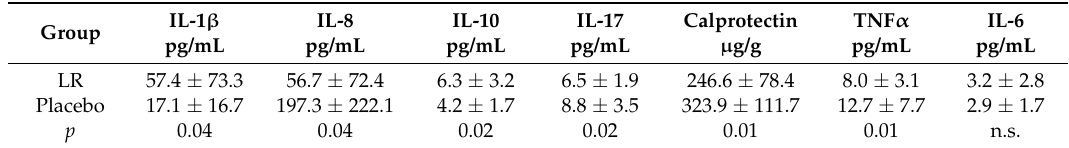
Table 3. Fecal cytokines.